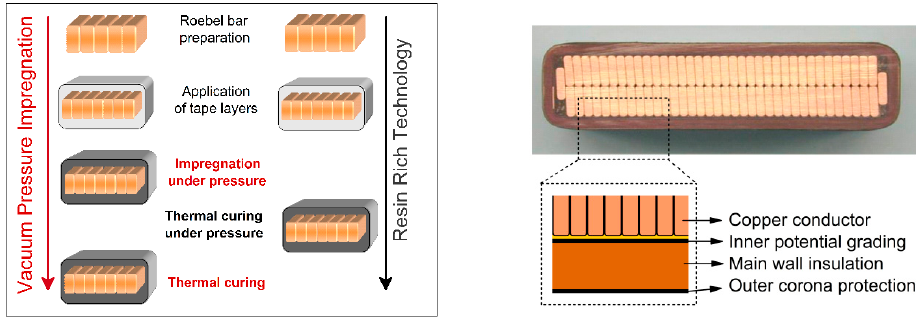
Figure 3. Vacuum pressure impregnation and resin rich processes in manufacturing high-voltage insulation composites of rotating machines stator bars (Redrawn and adapted figure from [13,14]).